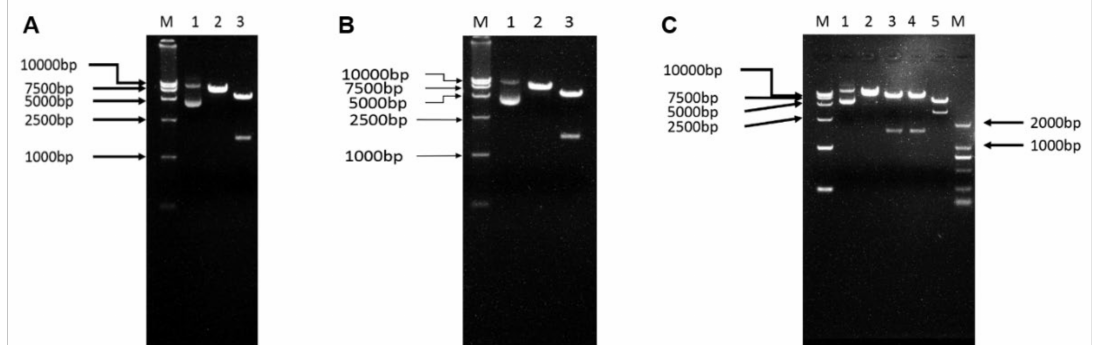
Figure 2. Restriction analysis for DNA vaccine. ( A , B ) Restriction analysis for pcDNA-BjLL and